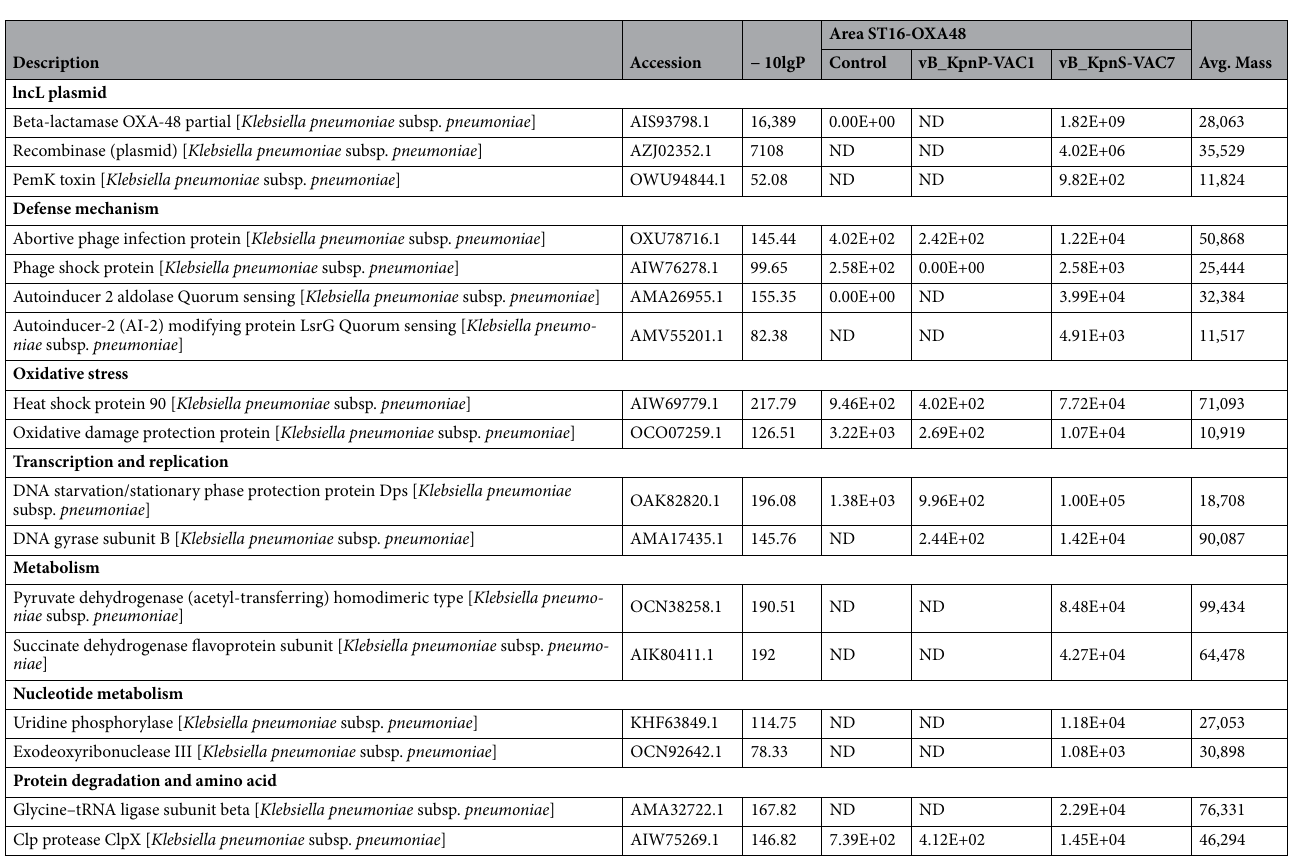
Table 2. Quantitative data on the protein profile of the clinical strain of K. pneumoniae ST16-OXA48 not infected and infected with the phages: vB_KpnP-VAC1 and vB_KpnS-VAC7. Description The protein header information as seen in the NCBI database (https:// www. ncbi. nlm. nih. gov). Accession The accession number of the protein as seen in the NCBI database, ‑10LgP the protein confidence score. Area the area under the